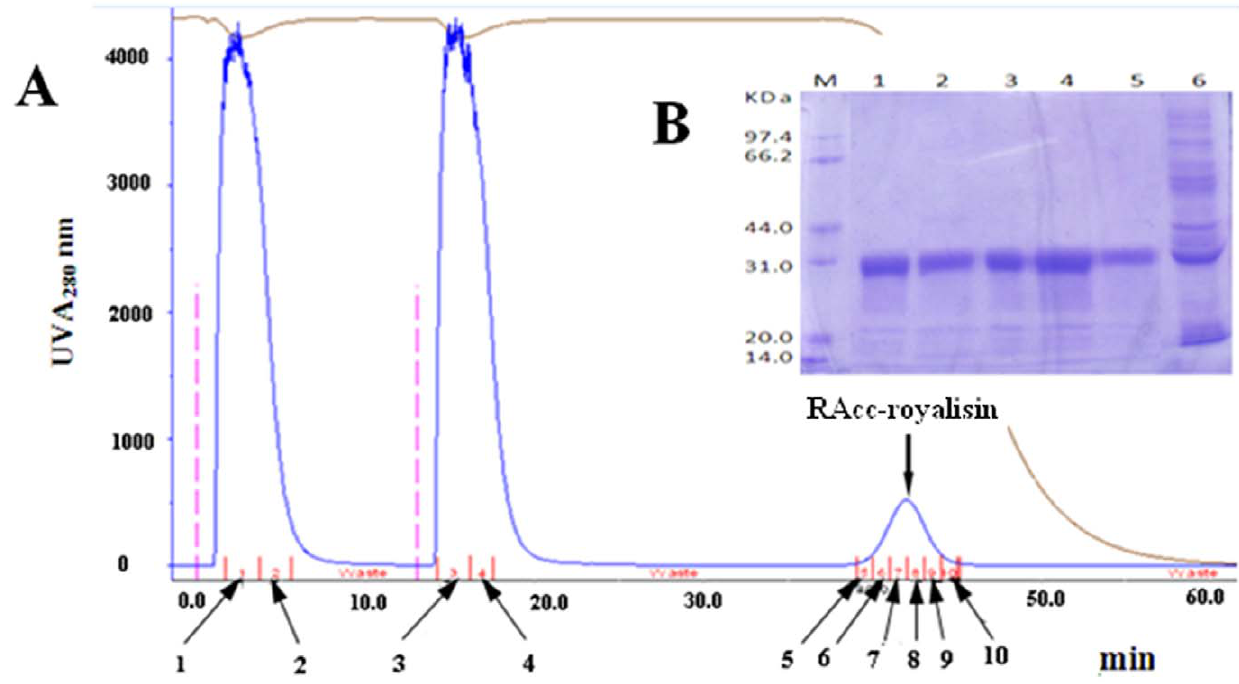
Figure 1. Purification diagram and SDS analysis of RAcc-royalisin. (A) The diagram of RAcc-royalisin purified at UV A 280 nm from the recombinant E. coli. 1–2 (indicated by arrows): The outflow peak of the first injection samples; 3–4 : The outflow peak of the second injection samples; 5–10 : The elution peak of RAcc-royalisin. (B) The SDS-PAGE pattern of the purified RAcc-royalisin. Lane M: Protein marker; Lane 1–5: The elution peak products; Lane 6: The outflow peak products.